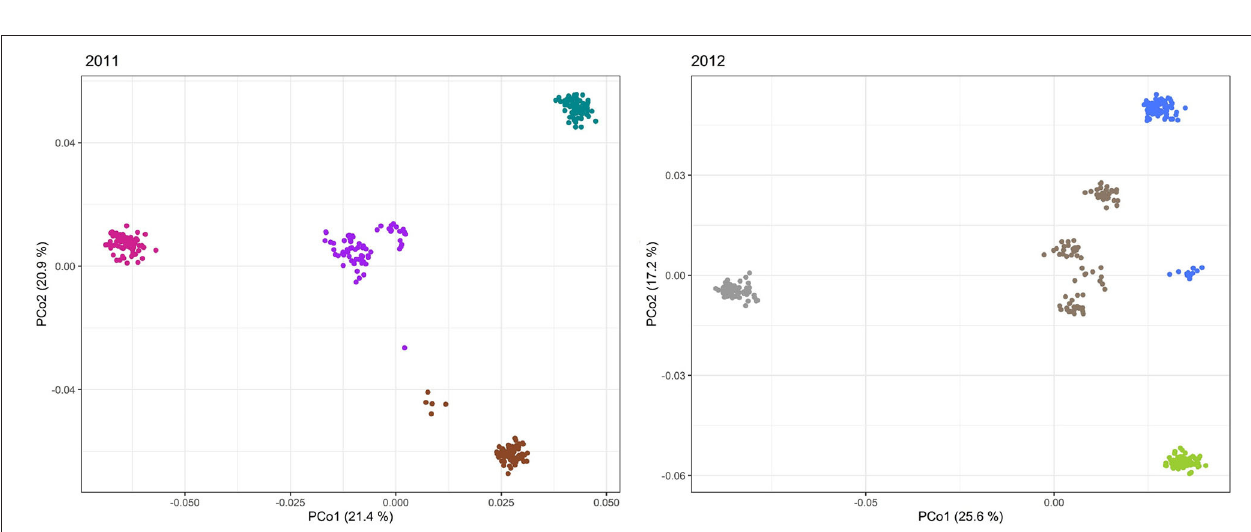
FIGURE 6 | Principal coordinates analysis (PCoA) of the 298 and 305 single cross rye hybrids in 2011 and 2012. Scatter plots of the first two principal coordinates based on genotyping data of 593 and 663 SilicoDArT TM markers, respectively. The horizontal and vertical coordinates represent PCo1 and PCo2. Each dot represents an accession. The samples are clearly stratified by ancestry. Samples are colored according to group assignment of the structure analysis.